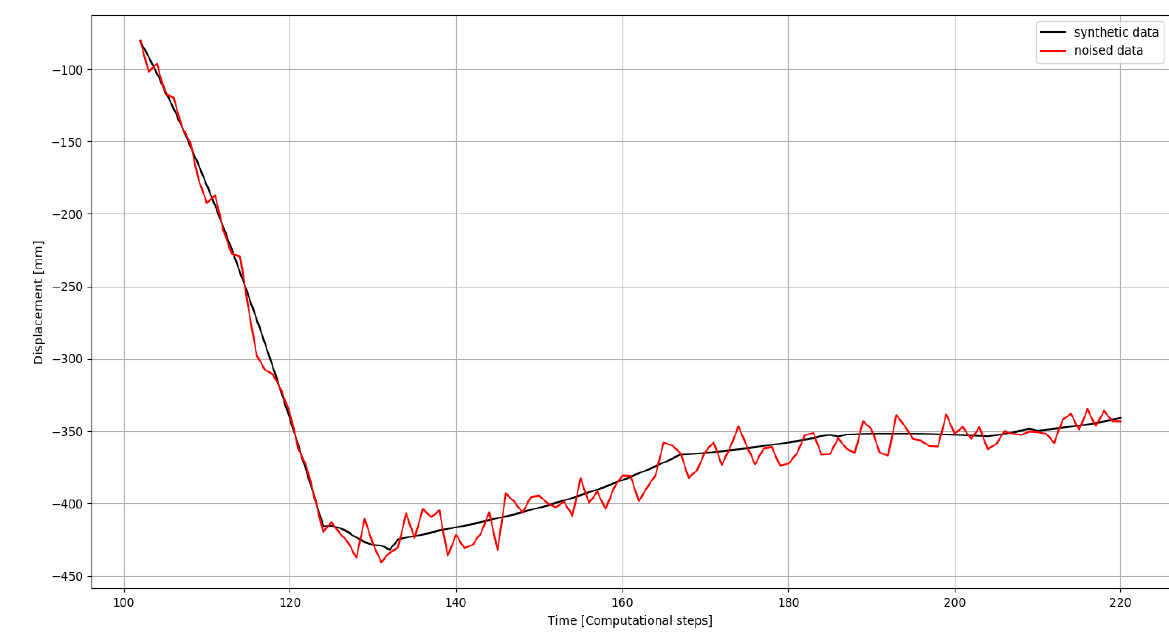
Figure 1: Example of noised